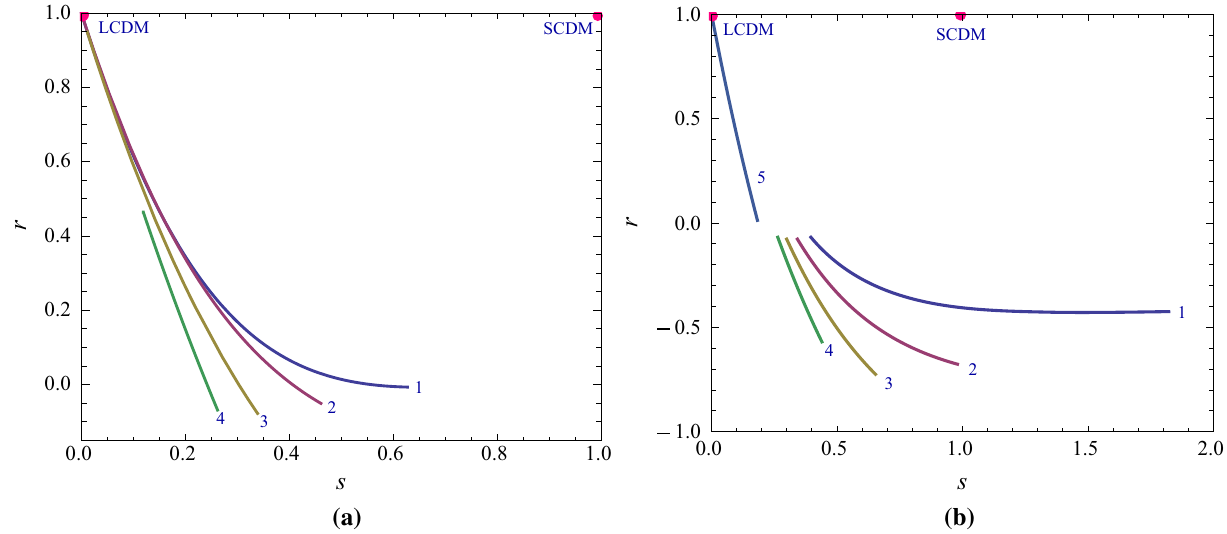
Fig. 2 The r − s trajectories has been plotted in the figure. We have taken H 0 = 10 and t 0 = 1 to plot the trajectories. The figure a is plot- ted for negative value of interaction rate (cid:10) = − 0 . 1 and the figure b is plotted for positive value of interaction rate (cid:10) = 0 . 005. In figure ( a ),